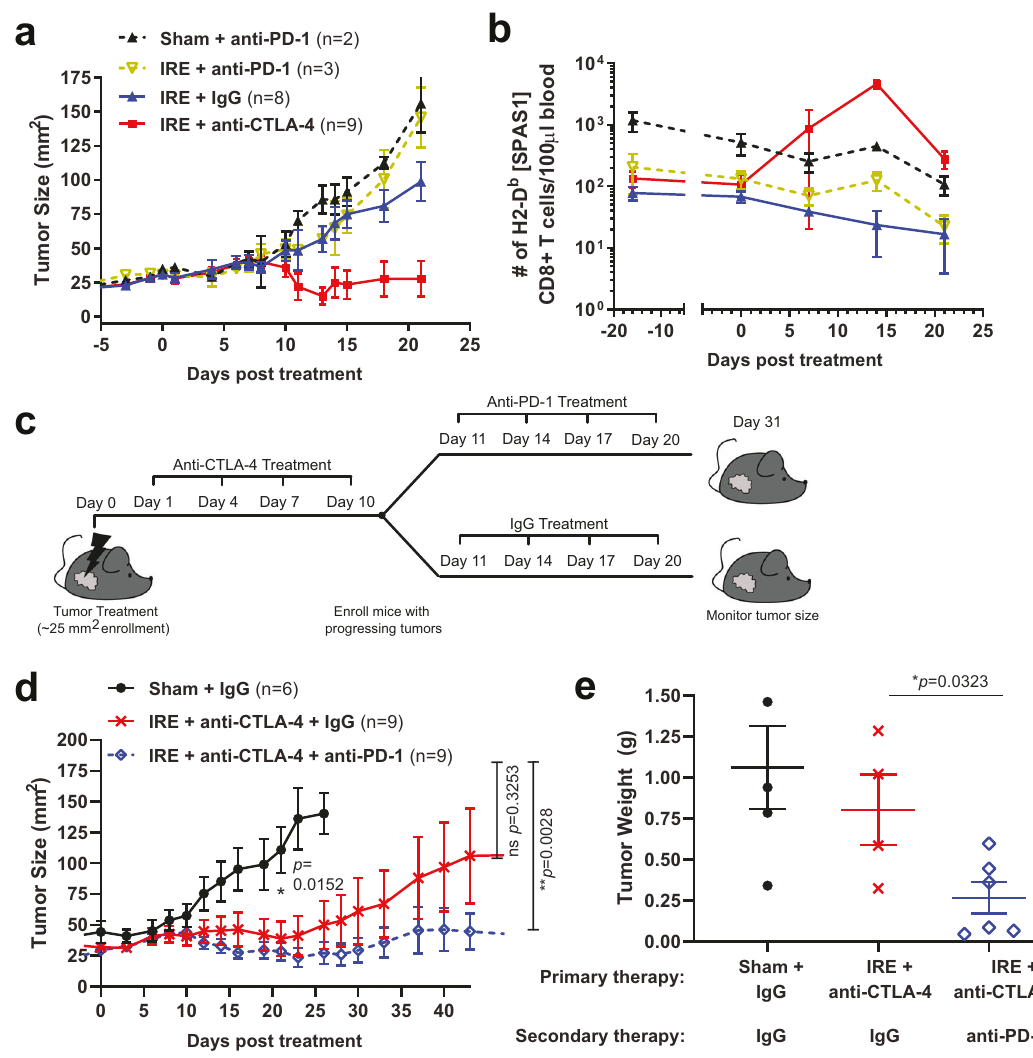
Fig. 9 Anti-PD-1 treatment following IRE plus anti-CTLA-4 combination therapy sustains tumor regression. a Mice bearing TRAMP-C2 tumors were treated with IRE or sham, followed by either IgG, anti-CTLA-4 or anti-PD-1 as indicated. Average tumor growth is shown. b The absolute number of SPAS-1 + T cells per 100 µ l of blood was determined by fl ow cytometry at days 0, 7, 14, and 21 following treatment in a . Data in ( a ) re fl ects 2 – 9 independent mice treated per group, of one representative experiment performed. Exact n values are shown for each group, with bars representing the mean ±S.E.M. Data in ( b ) re fl ects the analysis of blood from two independent mice from the experiment in ( a ), depicted as the mean ±the range. c Schematic of experimental design. Mice were injected in the fl ank with TRAMP-C2 cells as in Fig. 4. Tumors reaching 4 – 5 mm diameter were treated with IRE on day 0, followed by anti-CTLA-4 on days 1, 4, 7, and 10. On day 11, mice were randomly grouped for secondary therapy with 4 doses every 3 days of either IgG (control) or anti- PD-1. d Average tumor growth of each treatment arm, re fl ecting compiled data from n = 6 – 9 mice/group, pooled from two independent experimental cohorts. Unpaired two-tailed Mann – Whitney test was performed; * p < 0.05, **p < 0.01. All individual mice are shown in Supplementary Fig. 8b. e Surviving mice from ( d ) were euthanized on day 53 and tumors weighed; n = 4 for Sham + IgG and IRE + anti-CTLA-4 + IgG, n = 6 for IRE + anti-CTLA-4 +